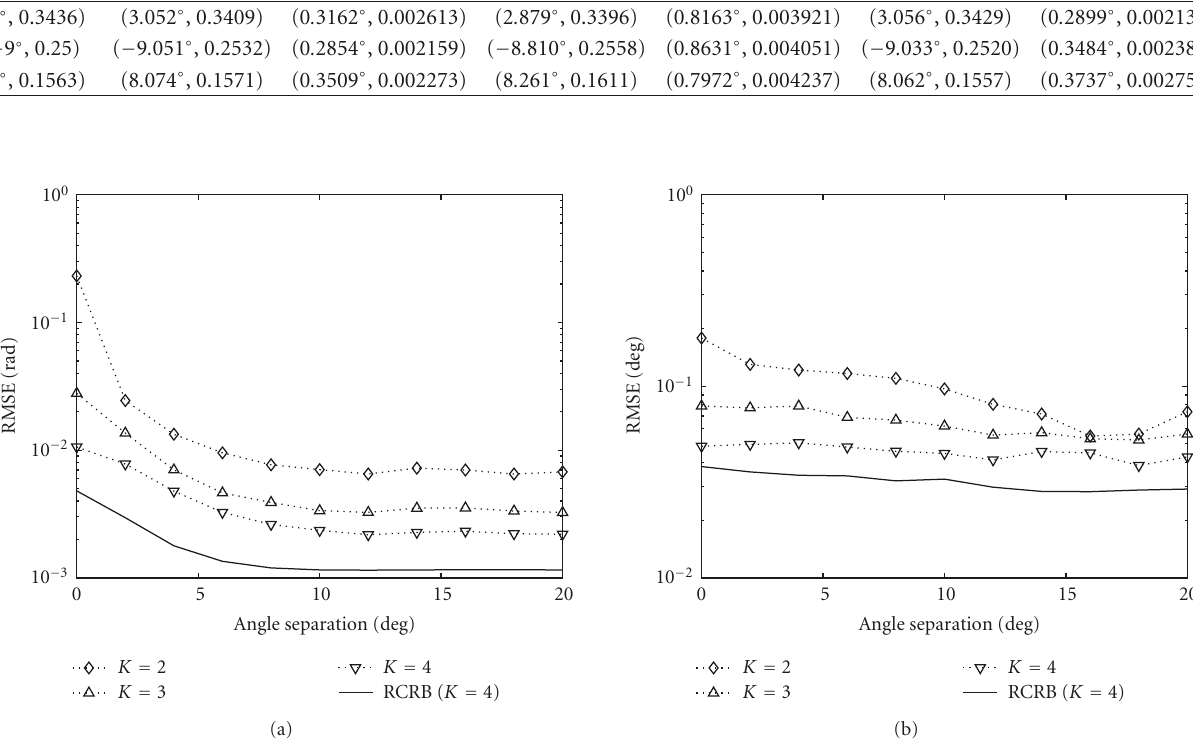
Figure 6: RMSE curves of the proposed method for frequency and DOA estimation of the first signal versus angle separation with fixed SNRs = 15 dB, M = 8, and N = 100. (a) Frequency estimation. (b) DOA estimation.